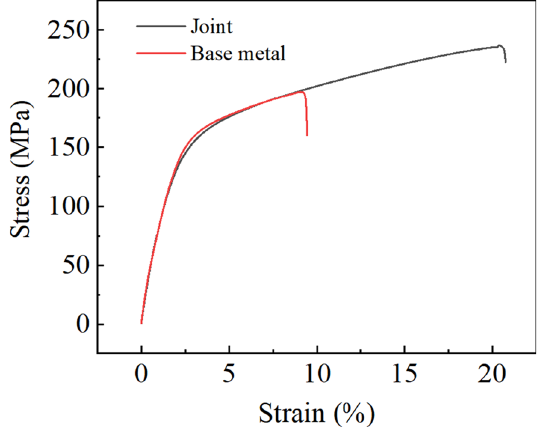
Fig. 7 Stress–strain curves of WE43 magnesium alloy EBW joint